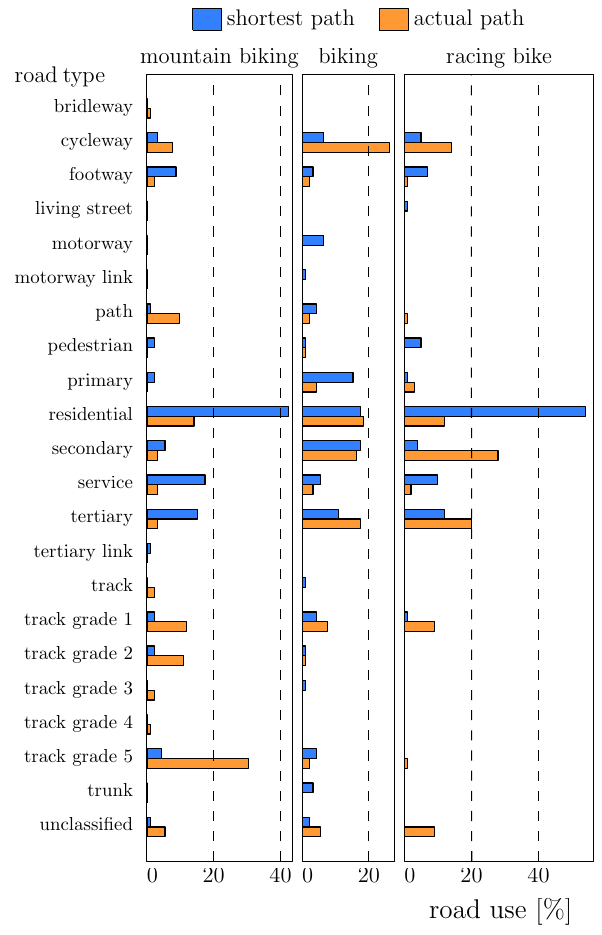
Figure 3. Share of different road types among the total length of the trajectories (orange) and the shortest paths connecting the same end nodes (blue), for each of the three types of bicyclists.